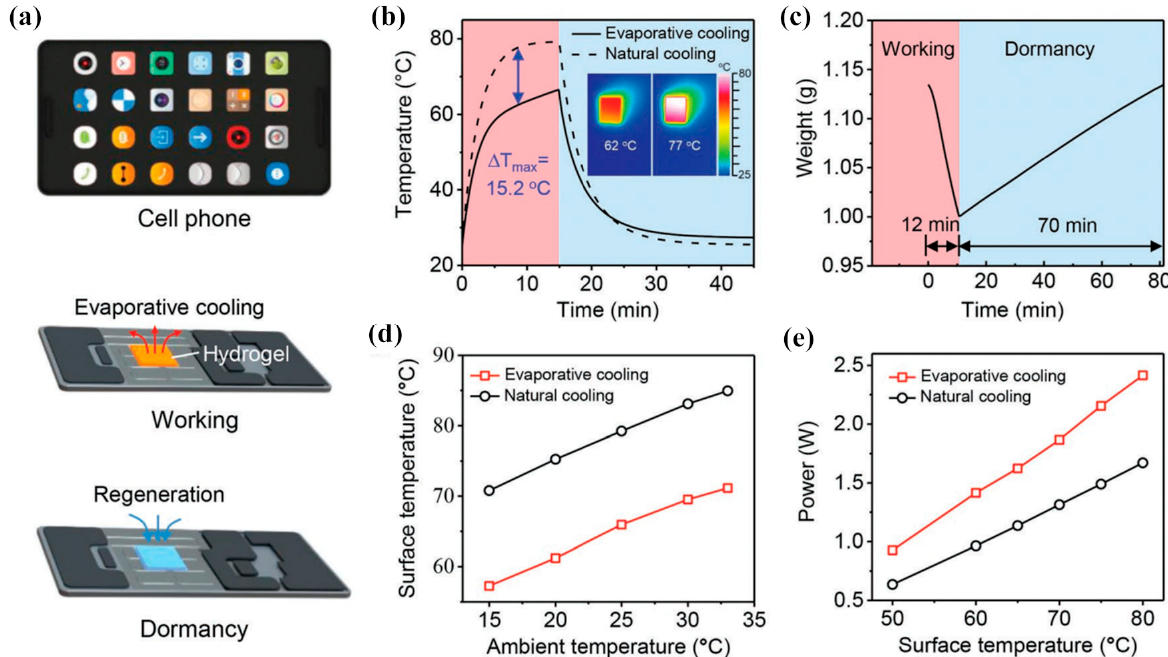
Figure 12. Evaporative cooling capability of Li-PAM hydrogel for mobile phone chip: ( a ) Cooling principle of Li-PAM based hydrogel; ( b ) Temperature variations of chips with and without the hy- drogel; ( c ) Weight variation of the hydrogel during the cooling and regeneration processes; ( d ) Chip temperature variation with ambient temperature during heating; ( e ) Maximum allowed power for chip with and without the hydrogel. Reprinted with permission from [129].